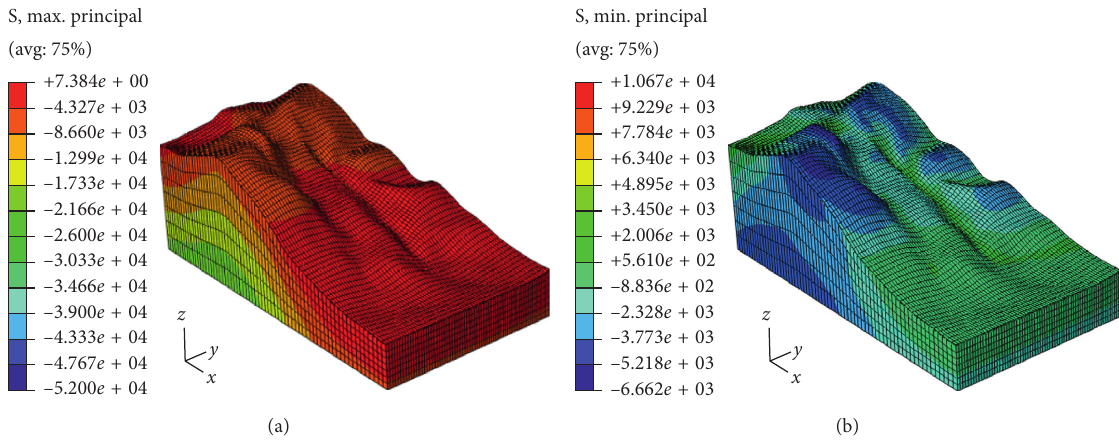
Figure 8: Distribution of stress field under condition 2. (a) Maximum principal stress field. (b) Minimum principal stress field.